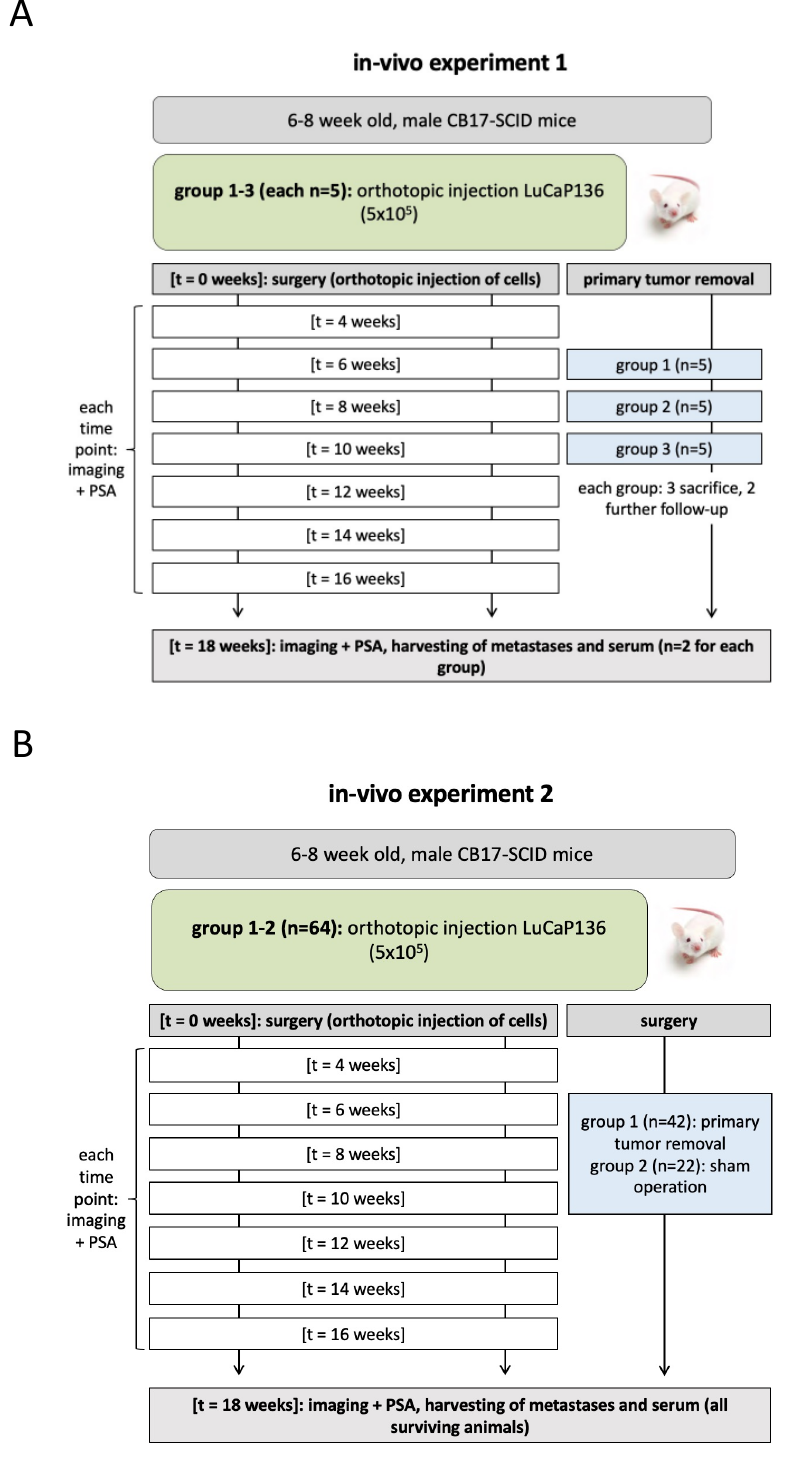
Figure 2. Schematic illustration of in vivo experiments. In experiment 1 ( A ), the optimal time point for cytoreductive primary tumor resection was determined. In experiment 2 ( B ), mice were randomized into a group that underwent primary tumor resection and a group that underwent a sham operation. The mice were further followed up to analyze the effect of primary tumor resection on disease progression and survival. PSA = prostate-specific antigen.